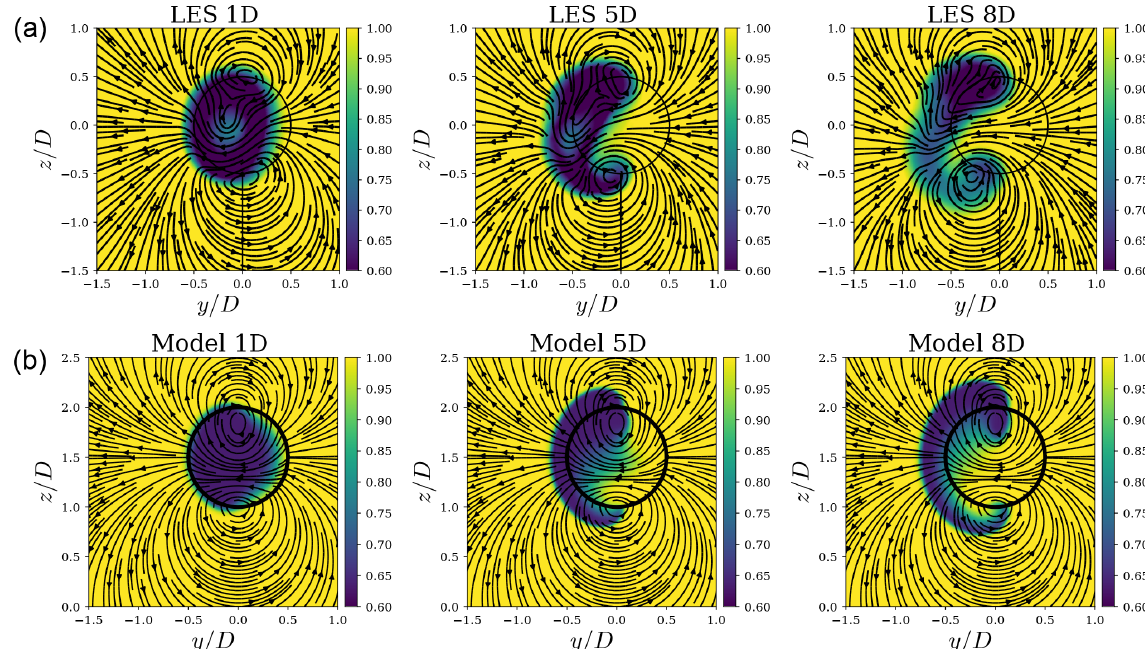
Figure 3. Comparison of streamwise velocity contours between a LES using an actuator line model under uniform inflow from Howland et al. (2016) (a) and the proposed model (b) . The streamlines show the spanwise velocity components.